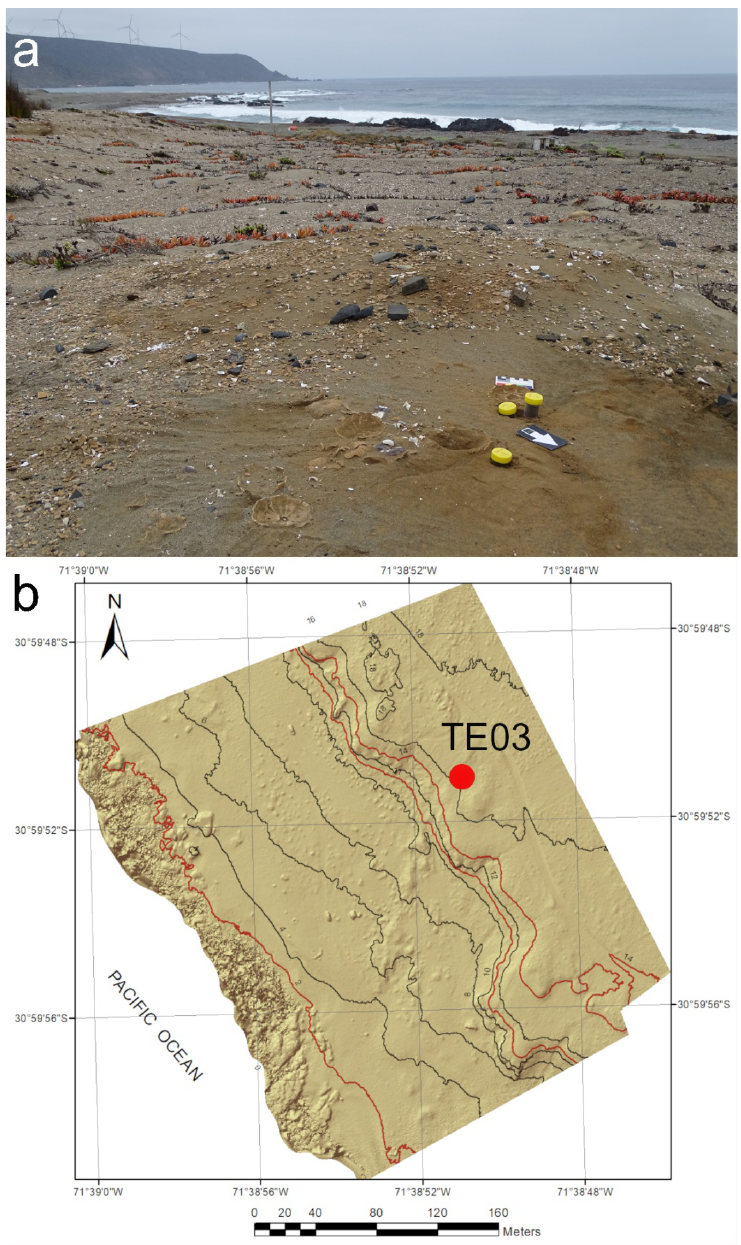
Figure 2. The La Terraza site: ( a ) exposed marine terrace and dated sample; ( b ) DEM of both marine terraces in TE03 indicating the site where the sample was collected for dating (red point). The contour lines are spaced at 2 m, and the main inflections are highlighted in red.